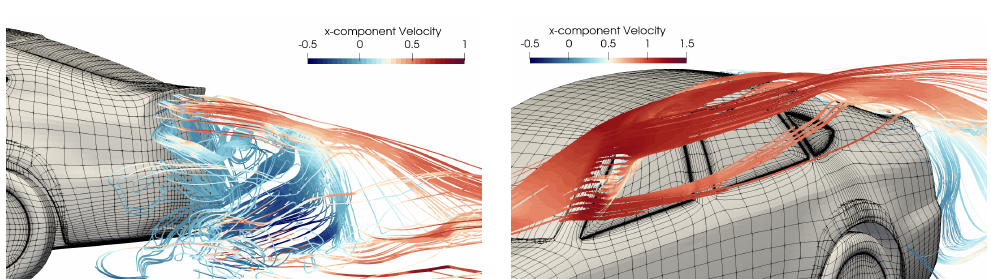
Figure 20. DrivAer model—Details of the streamlines coloured with the x -component of the velocity for the time-averaged solution near the rear-end ( left ) and the A-pillar ( right )